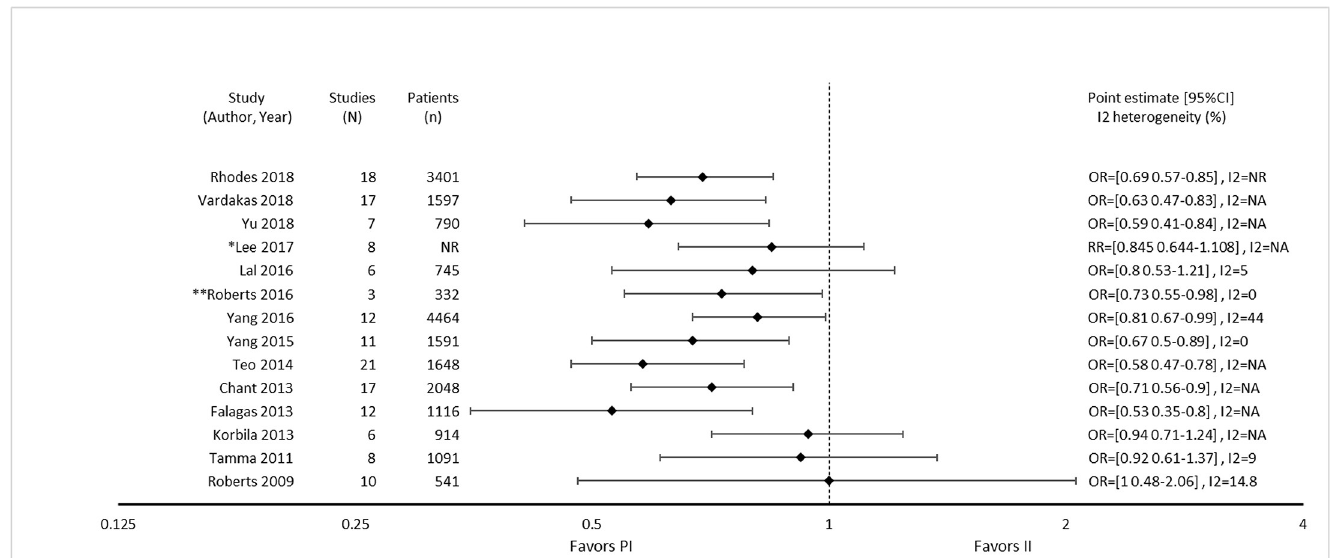
Fig 4. Effect of prolonged versus intermittent infusions of beta-lactam antimicrobials on mortality. � Lee 2017 –Did not report event rates. RR was therefore not converted to OR. �� Roberts 2016 –individual patient data analysis.